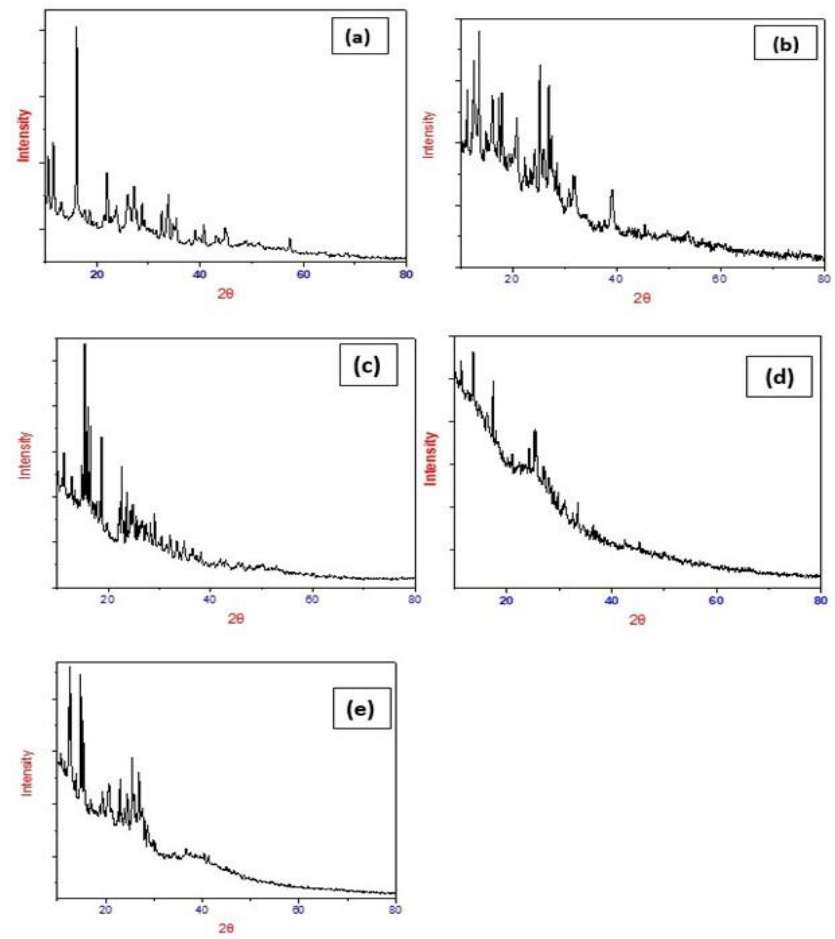
Figure 7. X-ray powder diffraction pattern for the ( a ) Mn(II), ( b ) Co(II), ( c ) Cu(II), ( d ) Cr(III), and ( e ) Pd(II) complexes.